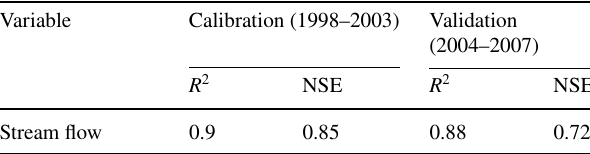
Table 8 NSE and R 2 values of Arc-SWAT estimation verses observed